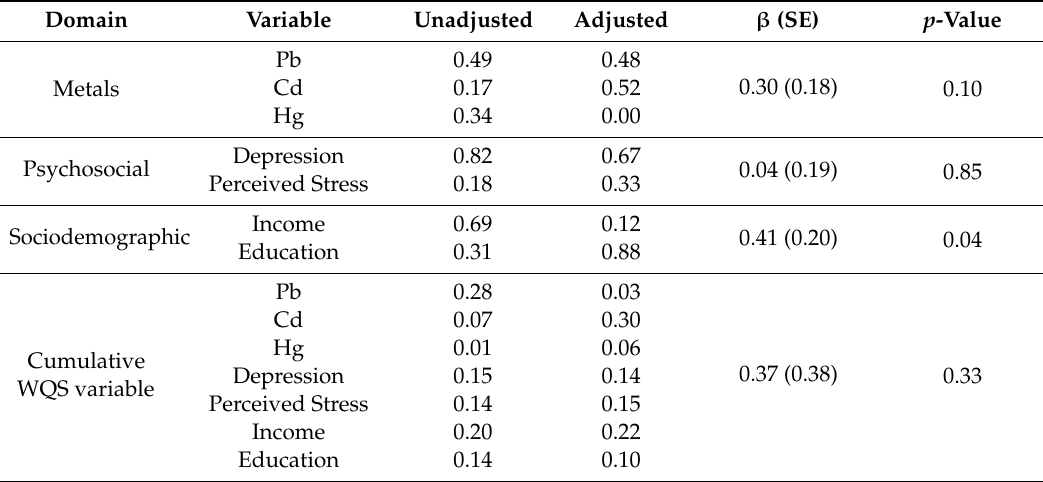
Table 5. Weights for adjusted and unadjusted weighted quantile sum (WQS) models, betas ( β ), and standard errors (SE) for final adjusted WQS regression models, Fetal Growth